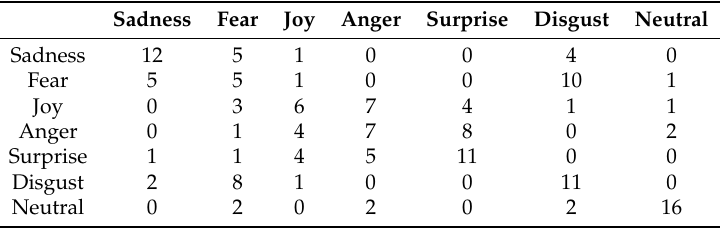
Table A9. P9 actor confusion matrix from the RekEmozio dataset in the second